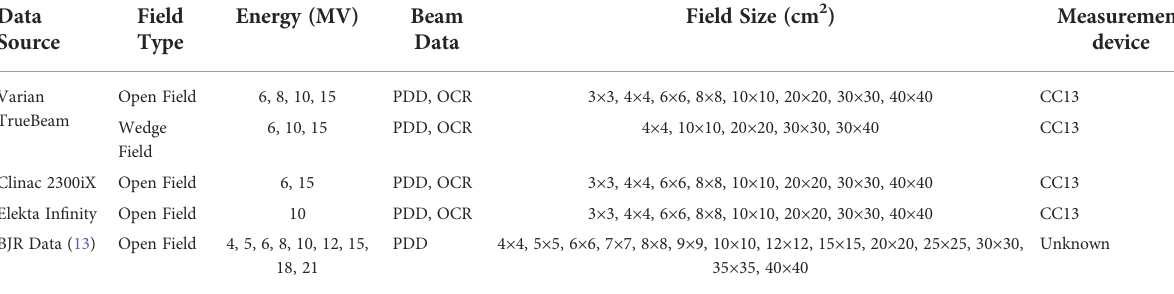
TABLE 1 Geometries of the Linacs beam data with multiple